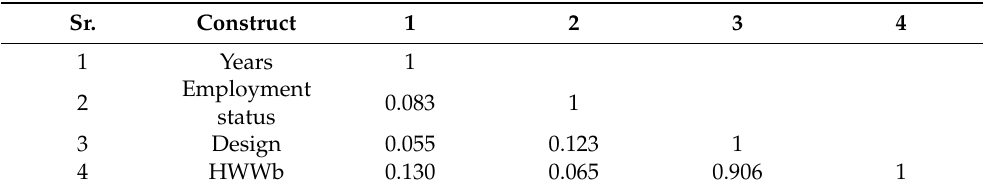
Table 7. Inter-Constructs’ Correlation.